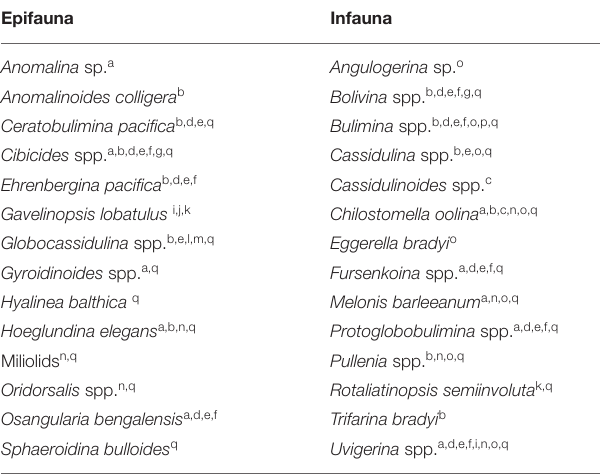
TABLE 3 | Microhabitat preferences for quantitatively significant benthic foraminifera recorded from the core SK 218/1.